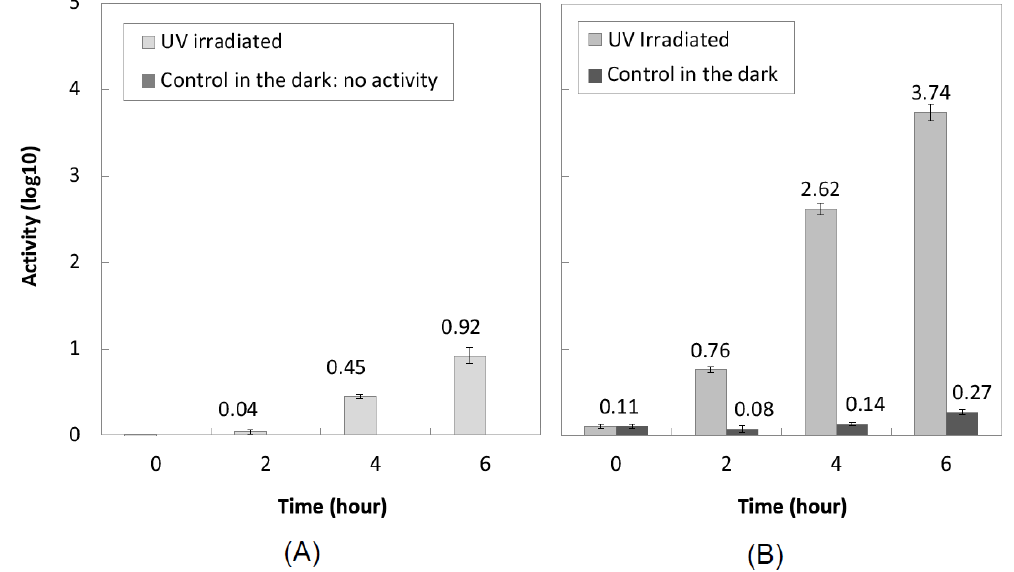
Figure 3. Antibacterial activity of TiO ( A ) standard conditions; ( B ) after application of a transparent plastic film on the inoculum. Mean ± SE, n =